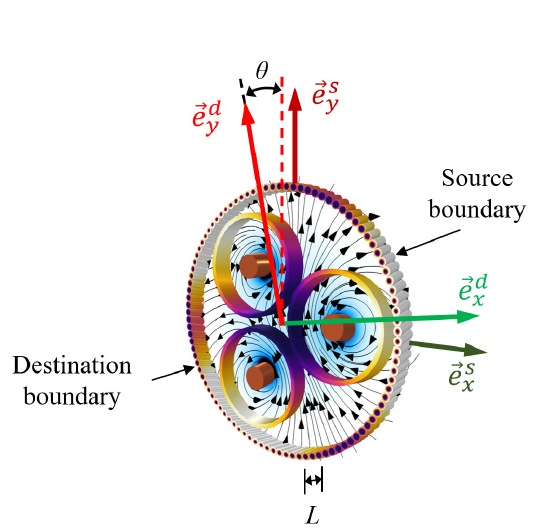
Figure 2. Rotated periodicity in a